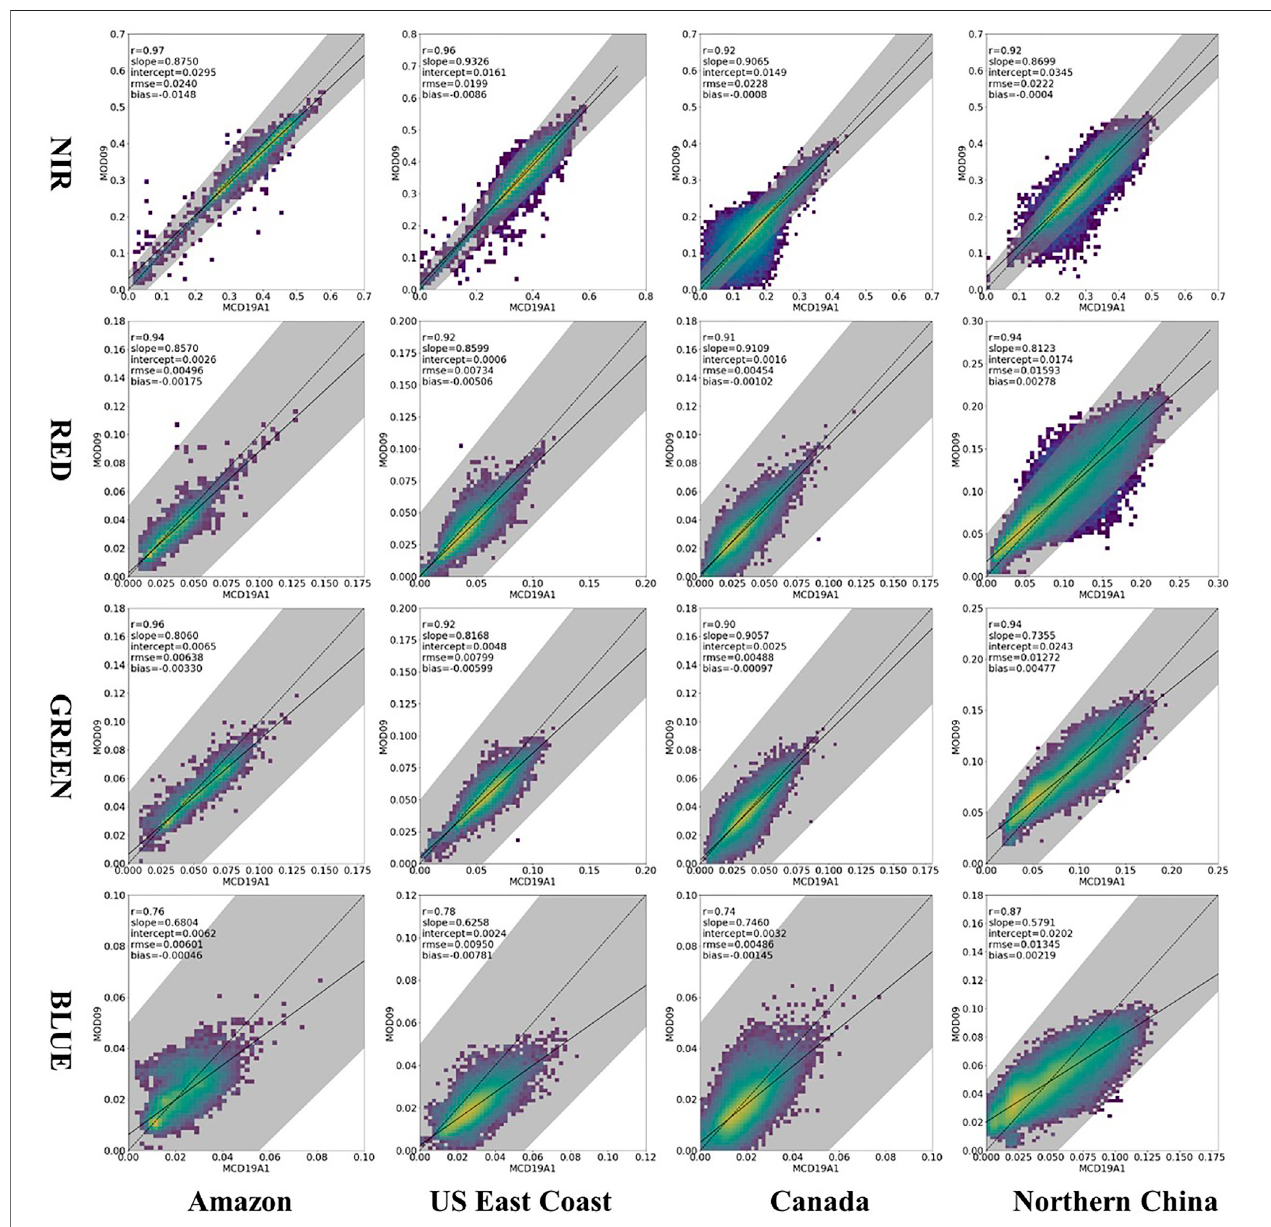
FIGURE 7 | MYD09 — MCD19A1 surface re fl ectance scatterplots of the best quality 5 × 5 km 2 aggregated pixels in four spectral bands across four study regions.